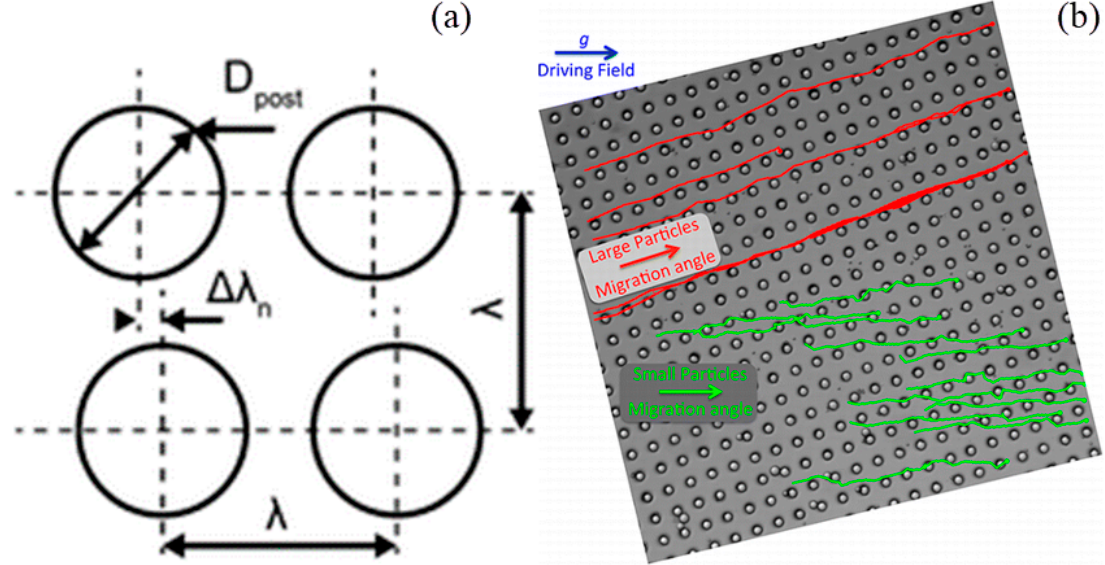
Figure 3. ( a ) Schematic of deterministic lateral displacement (DLD) chip with post placed at an angle to the flow direction. The figure has been reproduced with permission from the Royal Society of Chemistry [112]. ( b ) Microscopic image of gravity-driven deterministic lateral displacement (g-DLD) device. The figure has been reproduced with permission from the American Chemical Society [126].